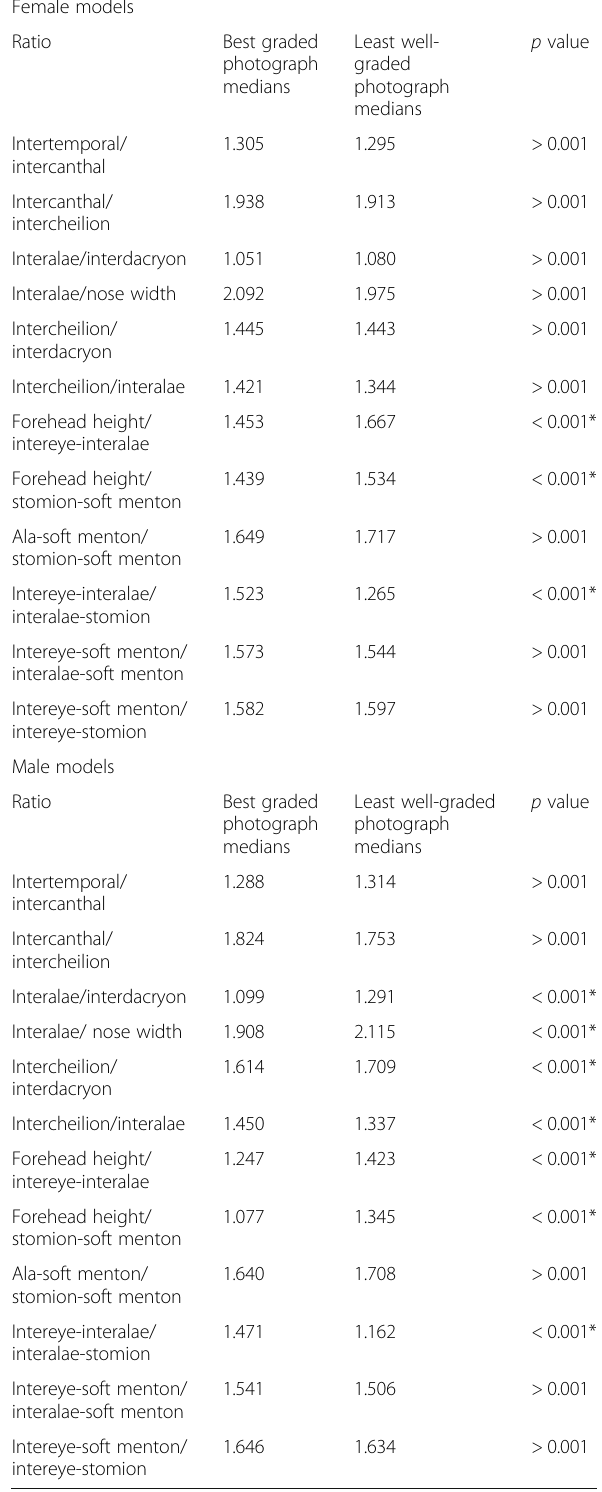
Table 5 Comparison of facial ratios between best graded